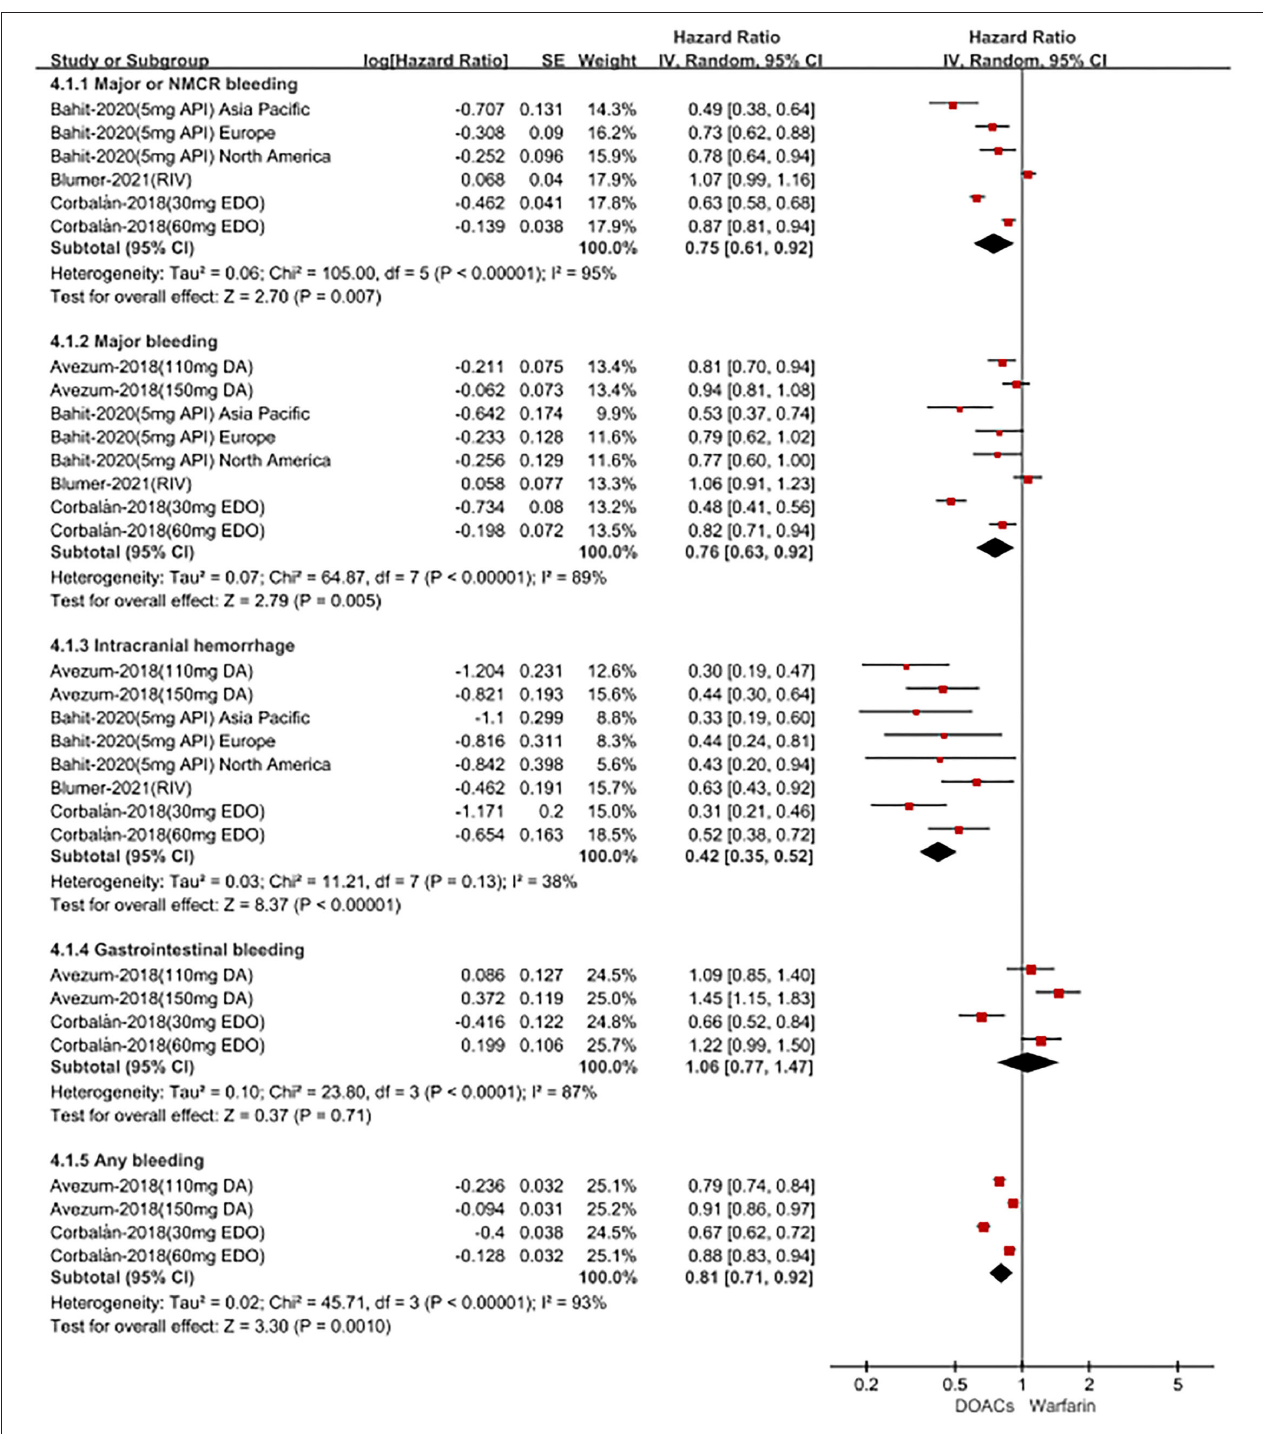
FIGURE 4 | Adjusted safety date of direct oral anticoagulants compared with warfarin in non-Latin patients with atrial fibrillation. DOACs, direct oral anticoagulants; DA, dabigatran; API, apixaban; EDO, edoxaban; RIV, rivaroxaban; CI, confidence interval.